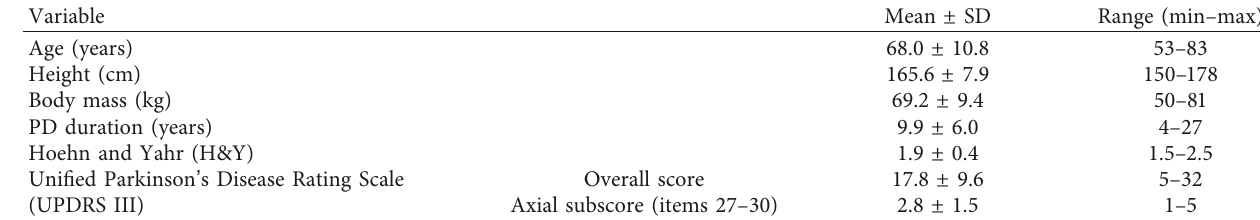
Table 1: Anthropometric and demographic aspects of